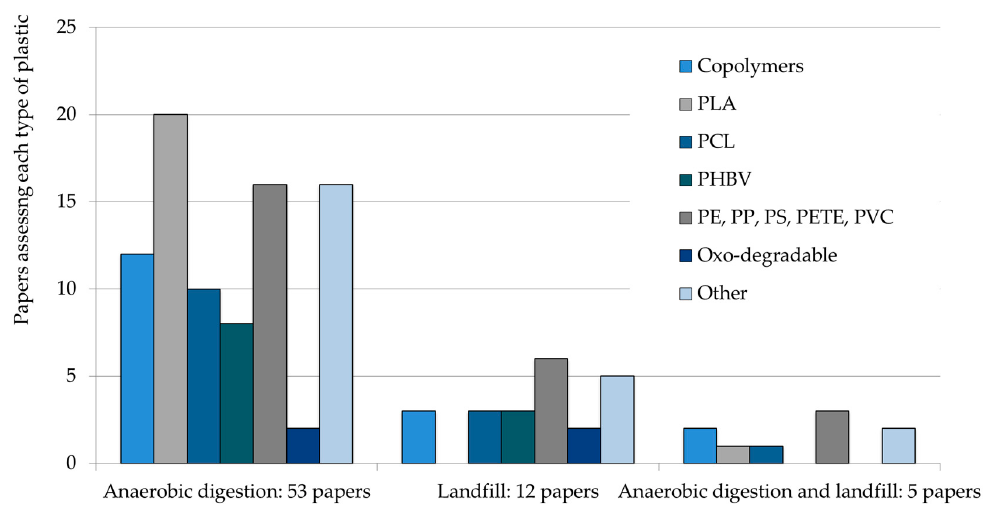
Figure 1. Biodegradation of different plastics under anaerobic conditions. Abbreviations: PLA, polylactic acid; PCL, polycaprolactone; PHBV, poly(hydroxybutyrate)-co-poly(hydroxyvalerate); PE, polyethylene; PP, polypropylene; PS, polystyrene; PETE, polyethylene terephthalate; PVC, vinyl chloride.